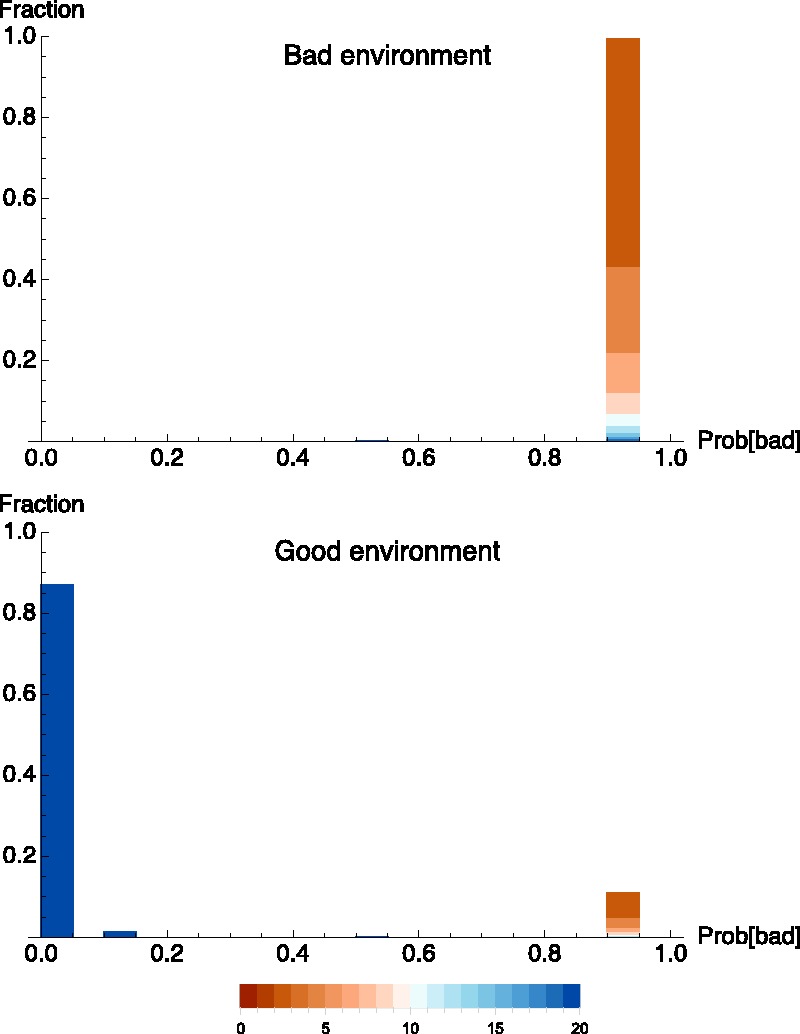
Population distribution of individual posterior probabilities that the environment is bad when the environment is indeed bad (upper panel), and when the environment is actually good (lower panel). The horizontal axis is the individual’s posterior probability estimate that environment is bad after 20 opportunities to dig at a burrow. (This is among foxes who have lived that long. Conditioning in this way introduces no sampling bias because survival is independent of environment and behavior in the model.) Frequency is plotted on the vertical axis. Color indicates the number of times an individual has sampled the environment. All individuals began with a prior probability of 0.5 that the environment is bad. When the environment is indeed bad, only 0.2% of the population erroneously believe the environment is likely to be good. When the environment is good, 11.1% of the population erroneously believes that it is likely to be bad. The majority of these individuals have sampled only a few times and then given up after a bit of bad luck